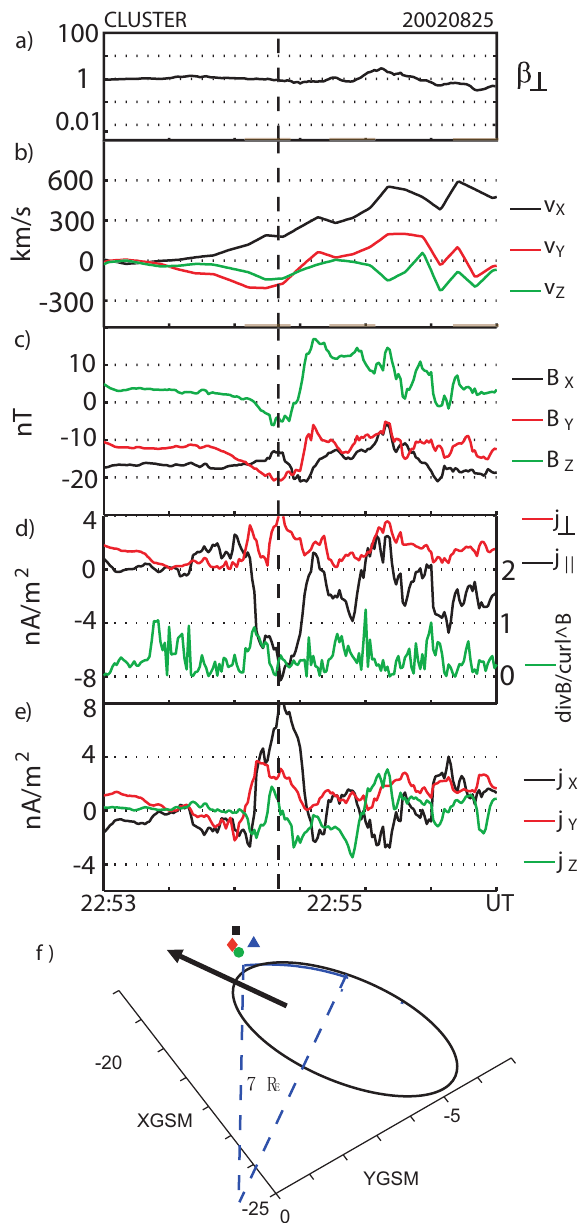
Fig. 12. Cluster measurements during a fast flow event on 25 Au- gust 2002: (a) proton β , (b) proton velocity and (c) magnetic field obtained by Cluster 1, and (d) perpendicular and parallel compo- nents of curl of B relative to the average magnetic fields and the ratio of curl of B to divergence of B and (e) X , Y , and Z compo- nents of curl of B. (f) Schematic presentation of the BBF and the spacecraft entering the fast moving plasma from the dawn edge. (Adopted from Snekvik et al.,